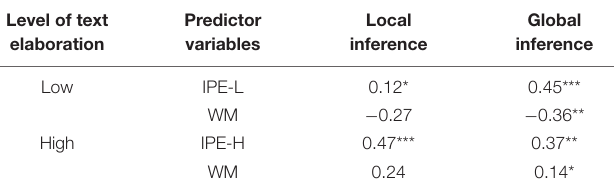
TABLE 10 | Summary of beta weights results from final step of hierarchical regression analyses predicting text recall from working memory and the immediate priming effect ( n =